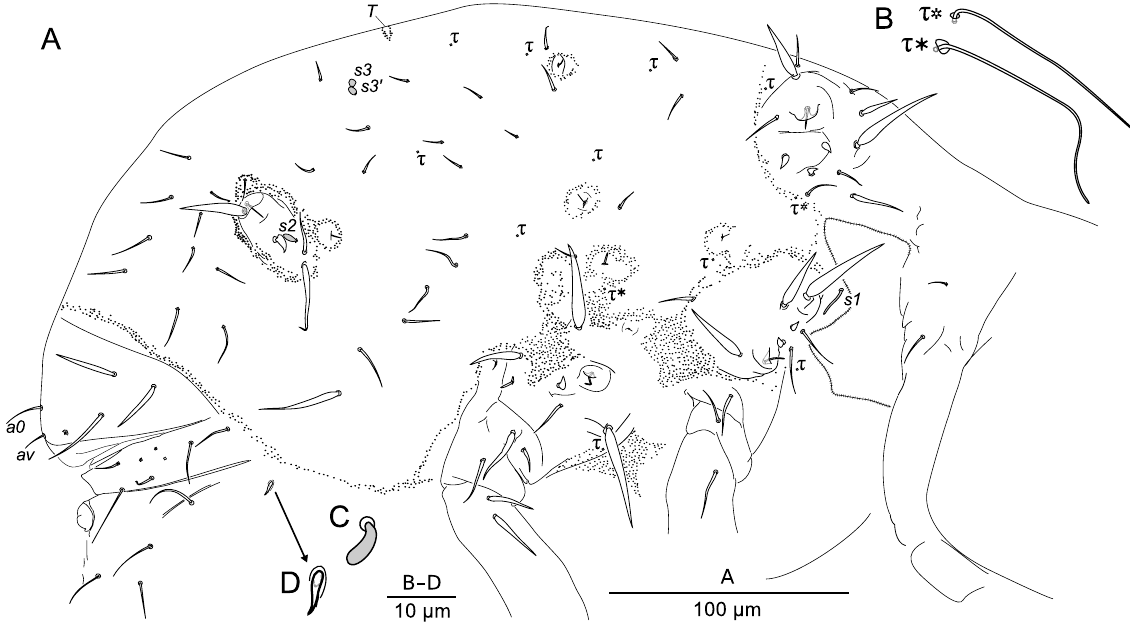
Fig. 4. Spinaethorax adamantis sp. nov. A . Chaetotaxy of the trunk. B . Focus on the τ-chaetae (asterisks link τ-chaetae in A and B). C . Focus on s-chaeta s2 . D . Focus on the neosminthuroid chaeta. Secondary granulation of Th.II–Abd.V terga partially shown (anterior, ventral and posterior limits, also limits near sensory fields and wrc1–8